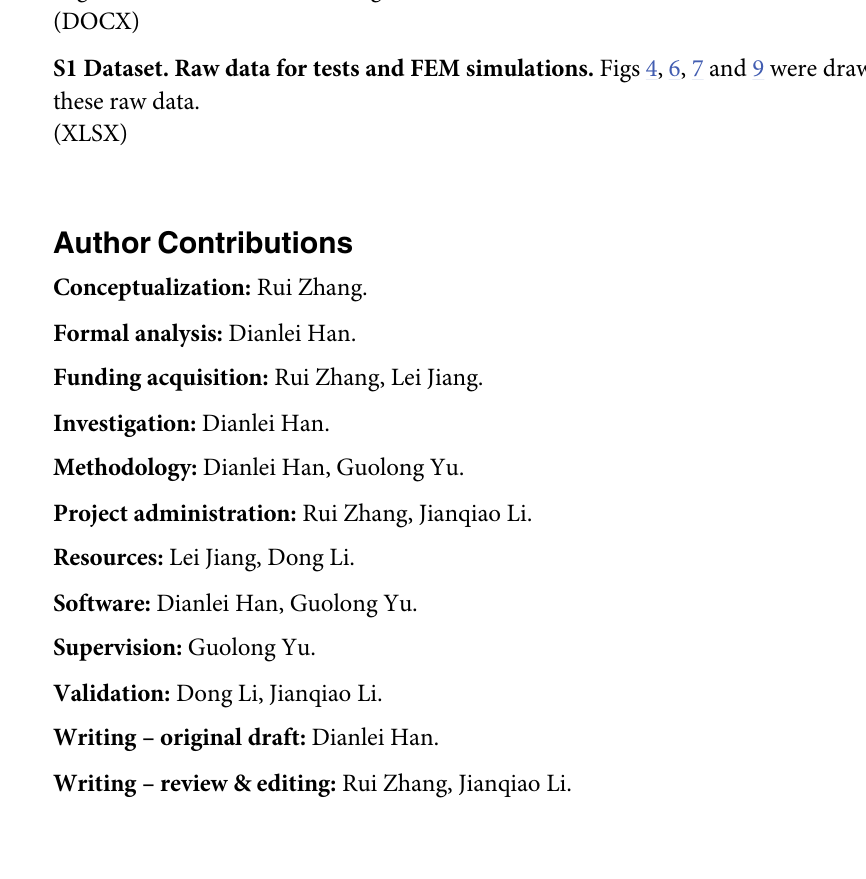
S1 Fig. Effect of hardness on cushioning performance in the tests. Cushioning performances of 15-, 30-, 45-mm-thick silicon rubbers with different hardness degrees on loose sand (A, C, E, respectively) and solid ground (B, D, F, respectively). S1 Table. Quantitative analyses of the effect of thickness on cushioning performance. Dec- rements of peak accelerations of 15, 35, 55 HA silicon rubbers with different thicknesses on loose sand and solid ground. S2 Table. Quantitative analyses of the effect of hardness on cushioning performance. Incre- ments of peak accelerations of 15-, 30-, 45-mm-thick silicon rubbers with different hardness degrees on loose sand and solid ground. S1 Dataset. Raw data for tests and FEM simulations. Figs 4, 6, 7 and 9 were drawn using these raw